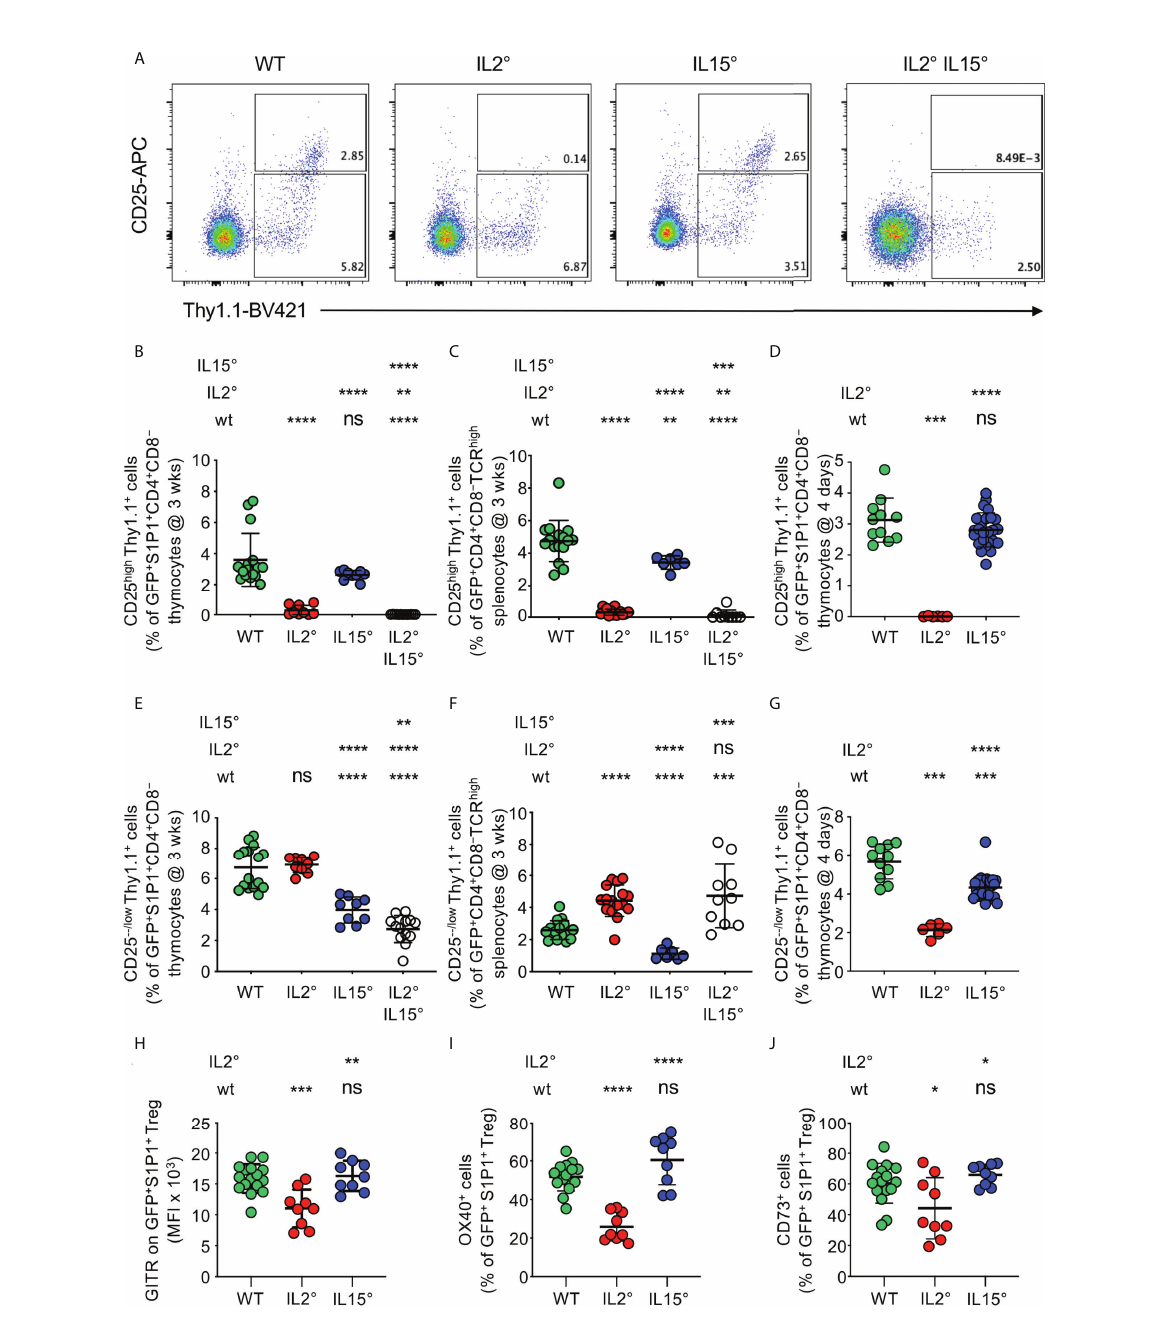
FIGURE 2 IL-2 and IL-15 differentially affect the phenotype of thymus exit-competent Treg. Thymocytes from Rag-Gfp Foxp3-Thy1 a mutant, Il2° and/or Il15° mice, and Il2 wt/wt and Il15 wt/wt littermates, were stained with fl uorescent antibodies against the indicated markers and analysed by fl ow cytometry. (A) Foxp3 vs. CD25 expression by GFP + S1P1 + CD4 + CD8 − thymocytes from indicated mice. Depicted gates were used to quantify CD25 − /low and CD25 high Treg. Percentages of (B – D) CD25 high or (E – G) CD25 − /low Treg among (B, E) newly developed S1P1 + CD4 + CD8 − thymocytes (n=16, 9, 9, and 13 wt, Il2°, Il15° , and Il2°Il15° mice, respectively) and (C, F) CD4 + CD8 − TCR high RTE in the spleen from three-week- old animals (n=16, 16, 7, and 9 mice), and (D, G) newly developed S1P1 + CD4 + CD8 − thymocytes from four-day-old animals (n=11, 6, and 25 mice). (H – J) Expression (MFI, % positive cells, as indicated) of indicated markers on GFP + S1P1 + CD69 low CD4 + CD8 − thymic Treg from indicated mice (n=16, 9, and 9 mice). Typical cytometry-plots are shown in Figure S3. ns, not signi fi cant; * p < 0.05; ** p < 0.01; *** p < 0.001; **** p < 0.0001 (Mann-Whitney test). Dots indicate individual mice. Bars indicate mean values ±